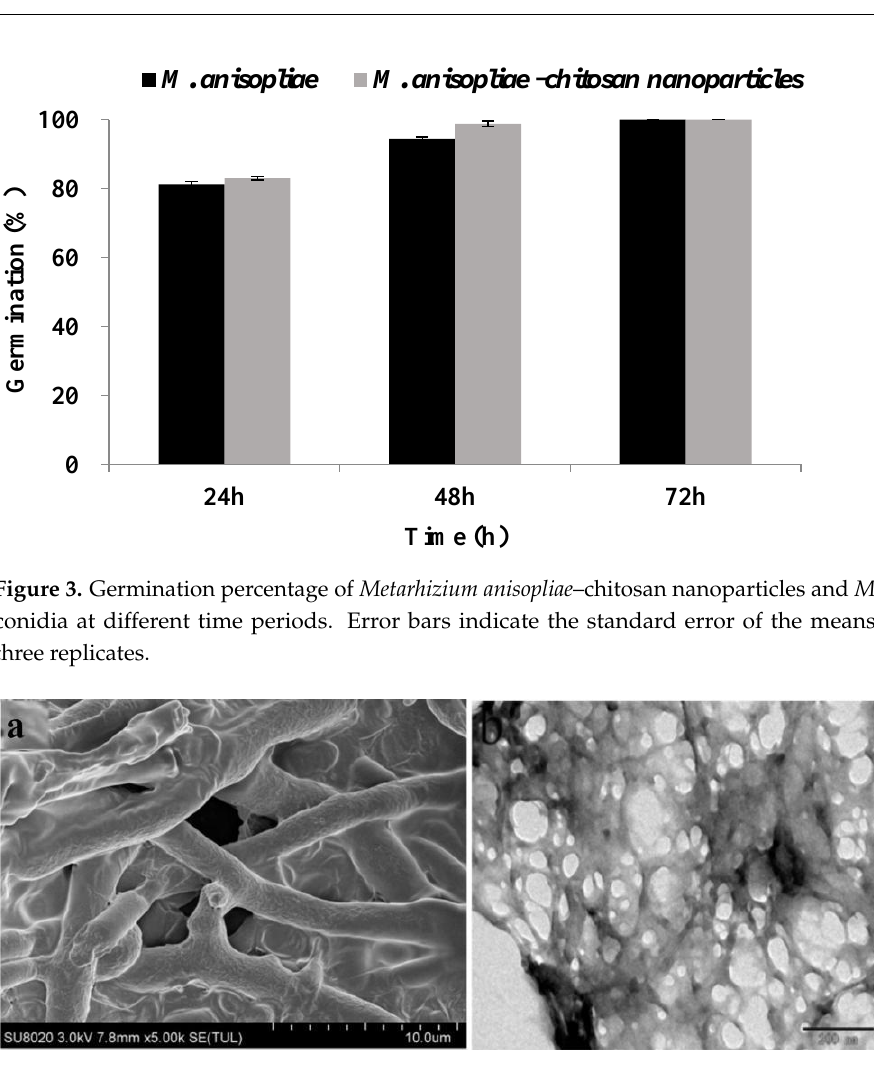
7 of 16 Figure 2. Median lethal concentrations (LC 50 ) of Metarhizium anisopliae SM036 against second instar Plutella xylostella larvae.Error bars indicate the standard error of the means based on three replicates. Bars with distinct letters at different days post treatment differed significantly from each other. 3.3. Characterization of Metarhizium anisopliae – Chitosan Nanoparticles